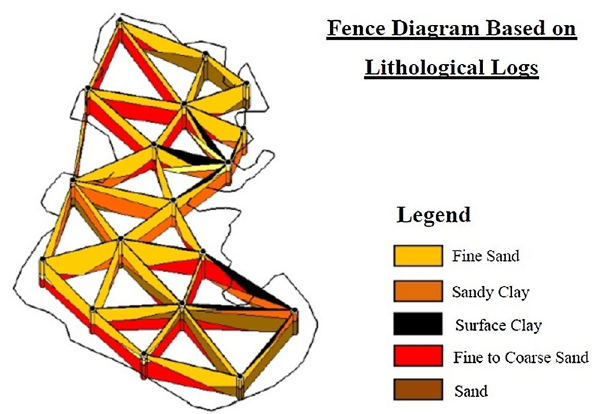
Fig. 3 Fence diagram based on lithological log data